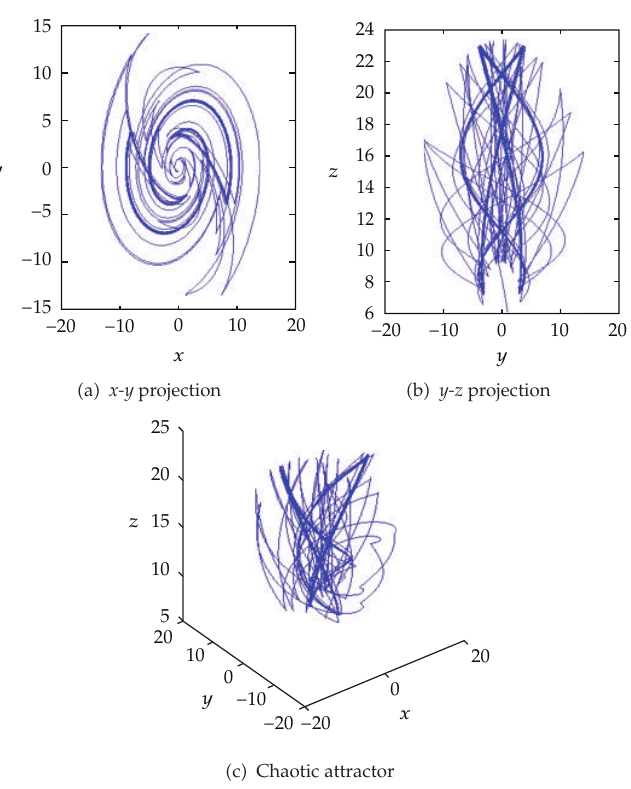
Figure 8: Chaotic attractor generated by F 1 (cid:7) 10, F 2 (cid:7)